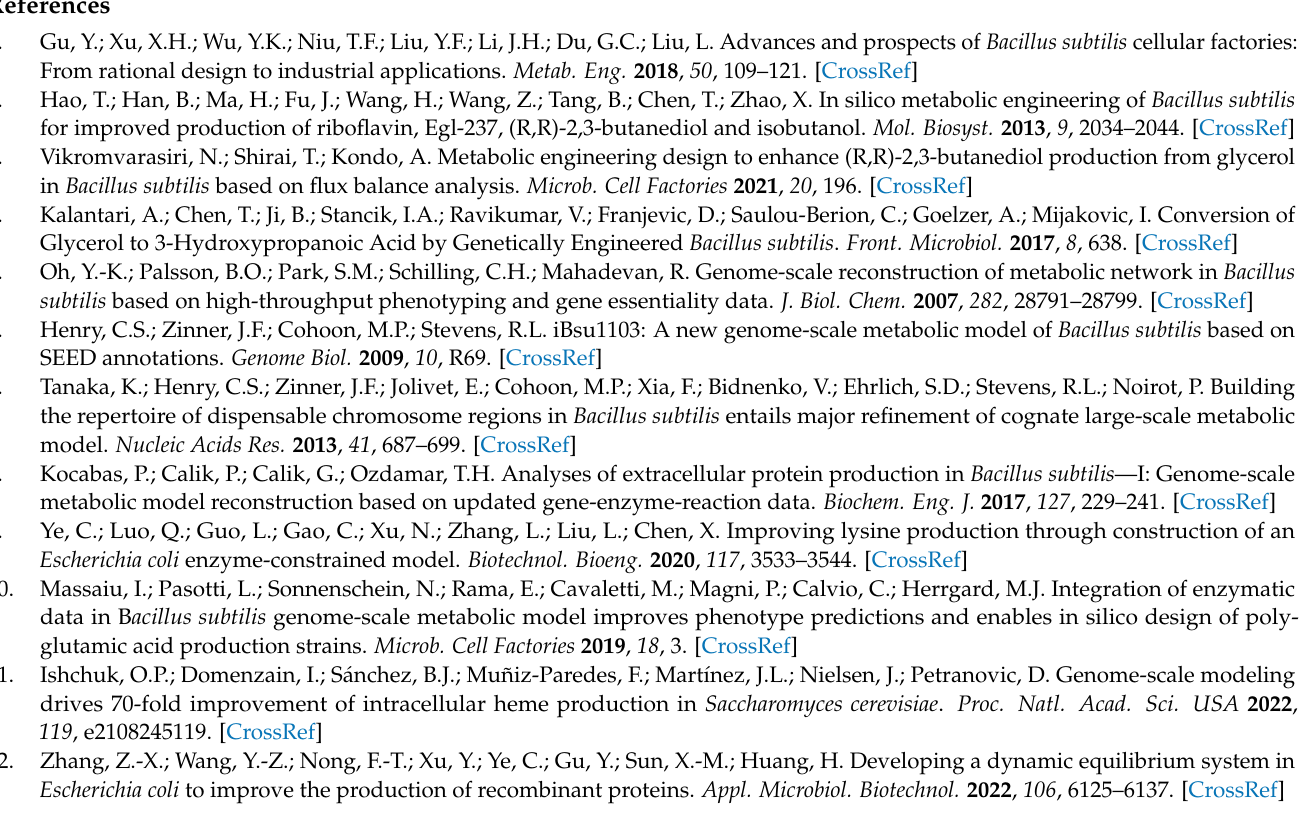
Table S2: EC number modification; Table S3: GPR modifications based on the GPRuler tool; Table S4: GPR modification based on homology; Table S5: Modification of reaction boundaries; Table S6: Biomass reaction standardization and mass balance using BiomassMW; Table S7: k cat in ecBSU1; Table S8: Reactions for k cat calibration; Table S9: Enzyme cost of energy metabolism; Table S10: Growth rates on different carbon sources predicted using iBsu1147 R and ecBSU1; Table S11: Target prediction based on enzyme